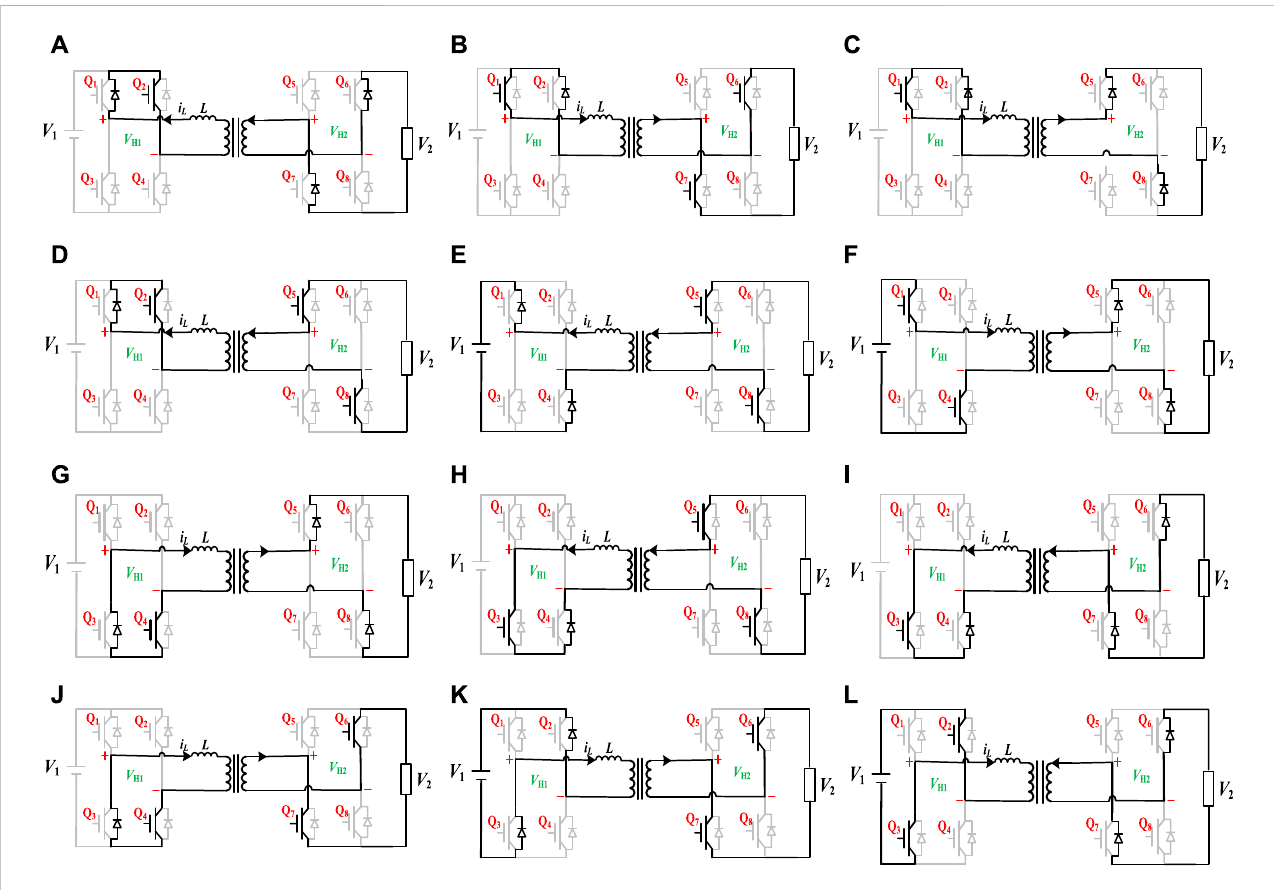
FIGURE 4 The circuit con fi guration of detailed ZVS analysis under optimized EPS mode: (A) period 1 from t0 to t1; (B) period 2 from t1 to t2; (C) period 3 from t2 to t3; (D) period4 fromt3to t4; (E) period5from t4to t5; (F) period 6fromt5to t6; (G) period7from t6to t7; (H) period8from t7tot8; (I) period9 fromt8to t9; (J) period 9 from t9 to t10; (J) period 10 from t10 to t11; (K) period 11 from t11 to t12; (L) period 12 from t12 to t13.